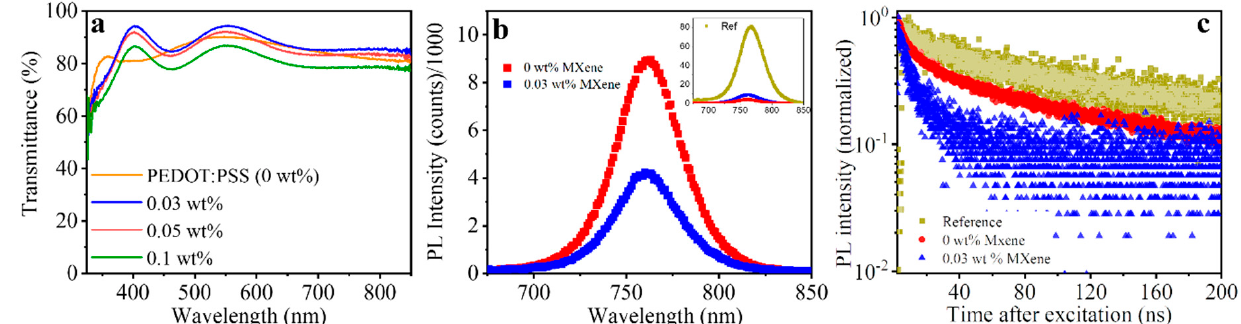
Figure 6. ( a ) Transmission spectra of PEDOT:PSS (0 wt.% MXene) compared with various doping concentrations of MXenes in PEDOT:PSS. ( b ) Steady-state photoluminescence spectra of perovskite films deposited on PEDOT:PSS (0 wt.% MXene) and 0.03 wt.% MXene-doped PEDOT:PSS; the inset shows the photoluminescence of the same compared with that of a perovskite film deposited on top of a non-quenching glass substrate. ( c ) Time-resolved photoluminescence decay transients of the various perovskite films. The perovskite films were excited from the glass side (HTL–perovskite interface) with a pulsed laser ( λ exc 405 nm).